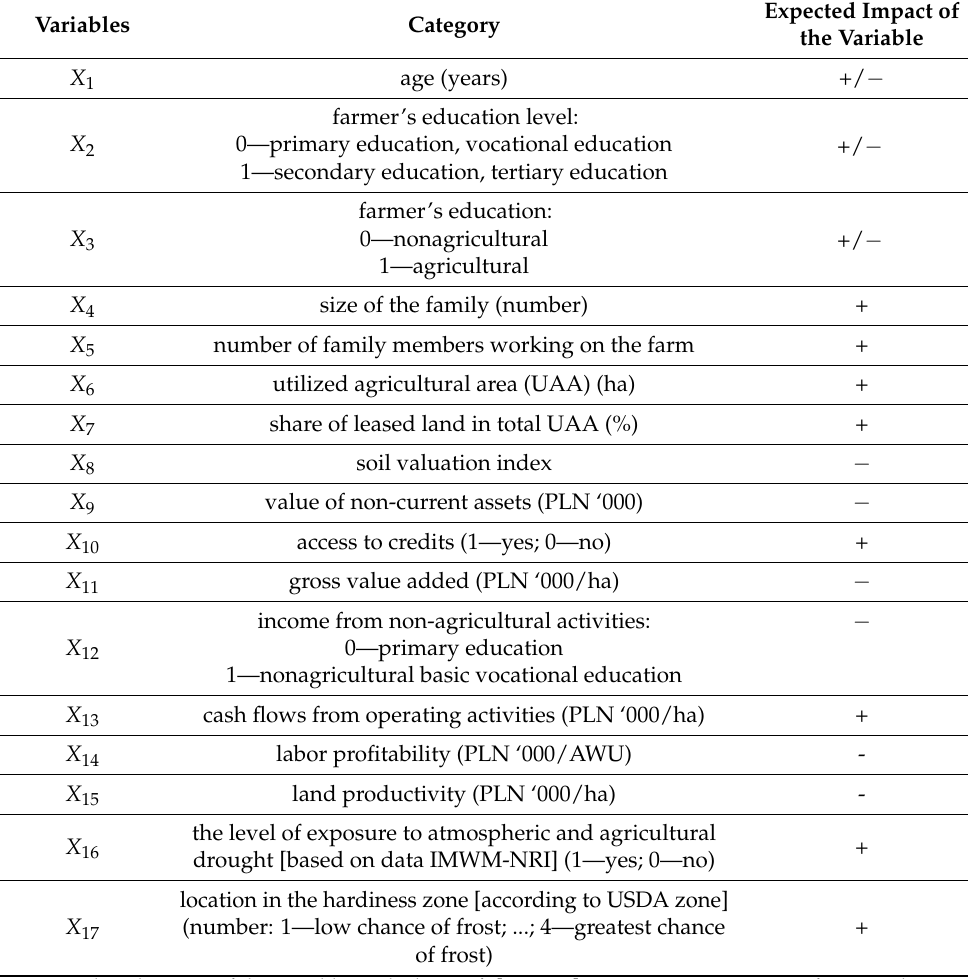
Expected Impact of the Variable